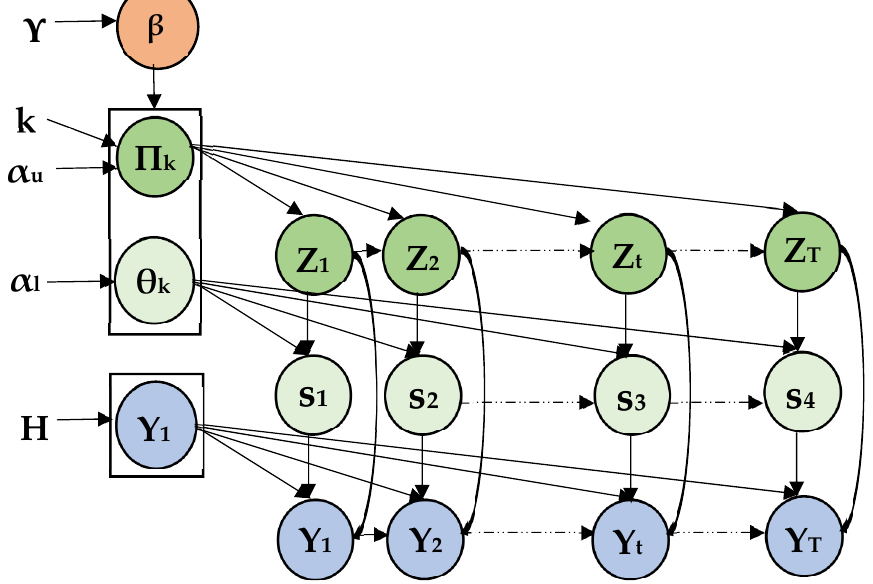
Figure 4. State-space diagram representation of the HDP-HMM with the DRP emissions.